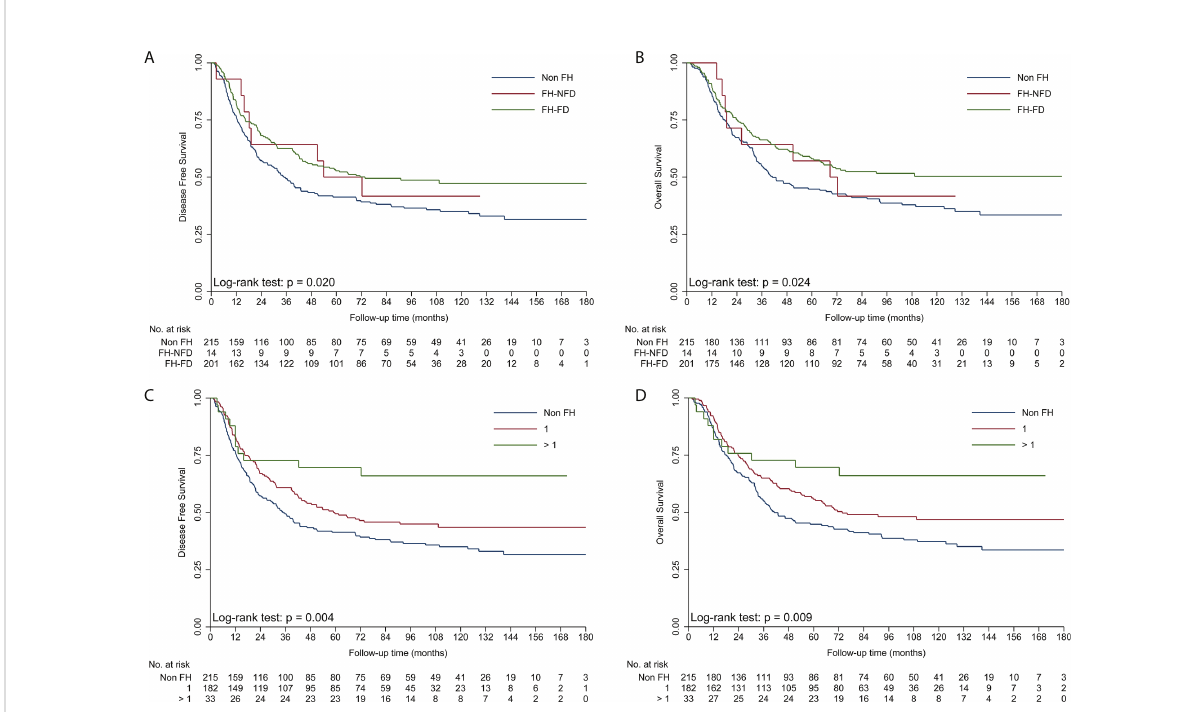
FIGURE 3 Kaplan – Meier curves showing better DFS (A) and OS (B) in the FH-FD group than in the non-FH group, but not in the FH-NFD group; Kaplan – Meier curves showing better DFS (C) and OS (D) in patients with more than one relative affected by cancer than in patients in the non-FH group. DFS, disease-free survival; FH, family history of cancer; FH-DC, family history of digestive tract cancer; FH-NDC; family history of non-digestive tract cancer; FH-NFD, family history in non- fi rst-degree; non-FH, no family history of cancer; OS, overall